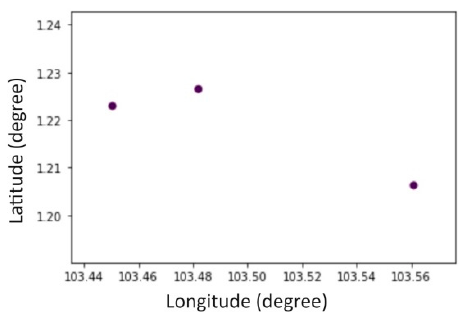
Figure 13. Result of DBSCAN at 1900.